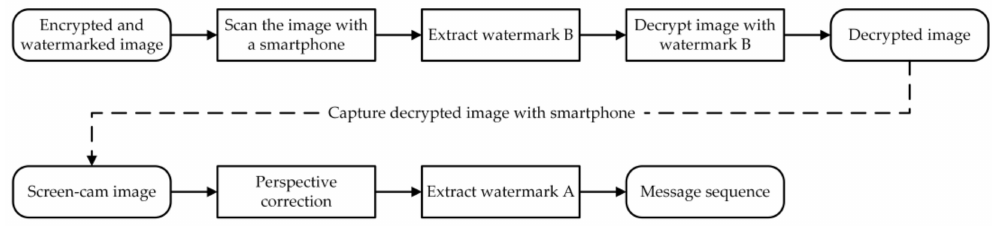
Figure 8. Framework of extraction and decryption process.